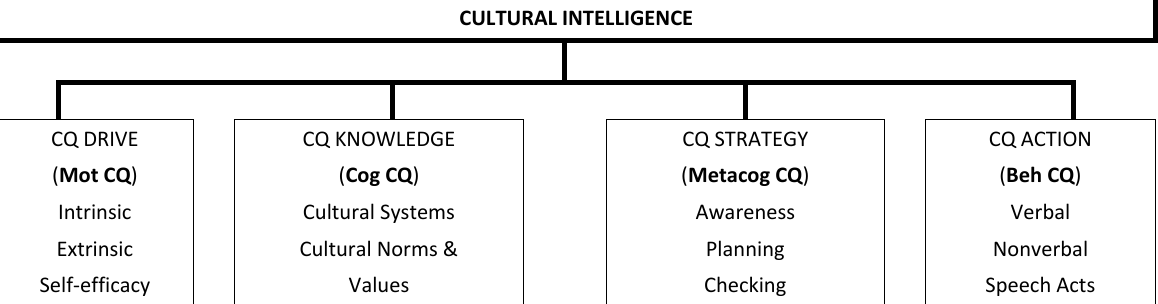
Table 1. CQ conceptualization.